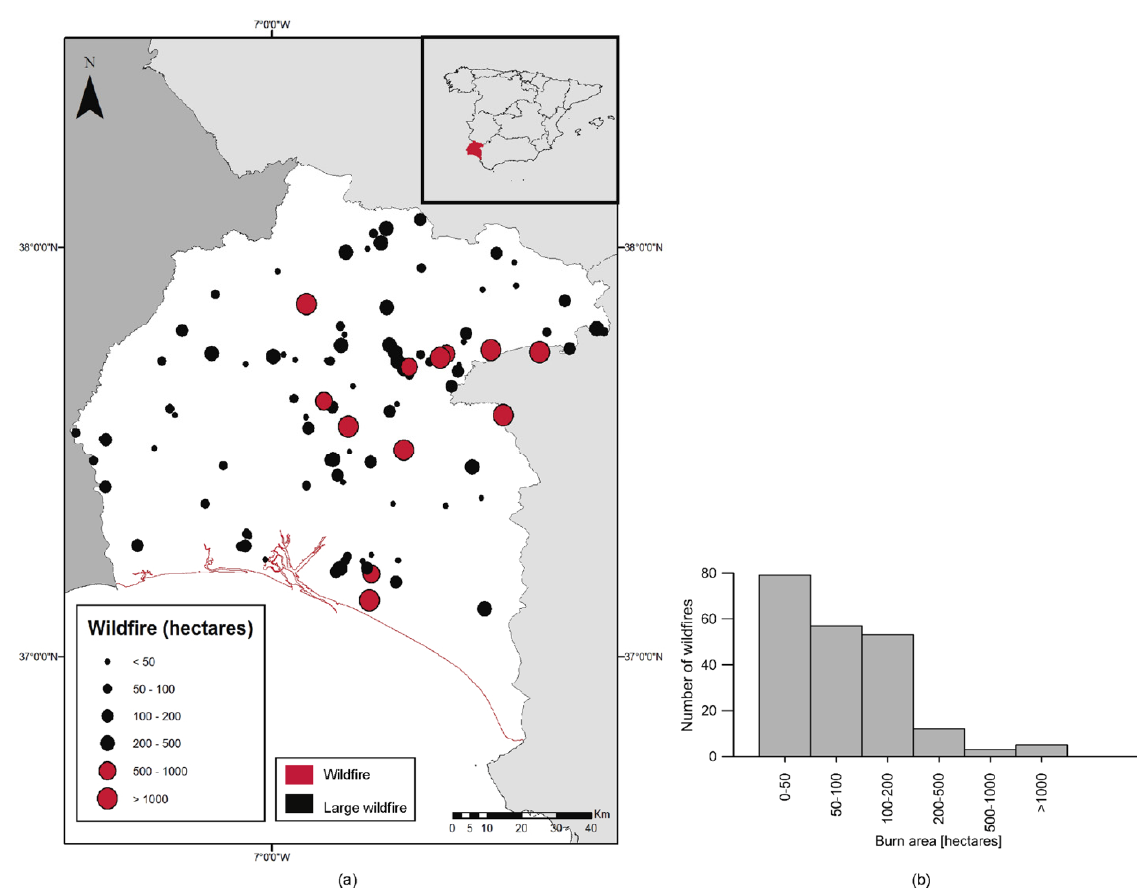
Figure 1. Distribution of wildfires: ( a ) Location of wildfires within study area between 2000 and 2018, and ( b ) histogram of frequency of wildfires by area.